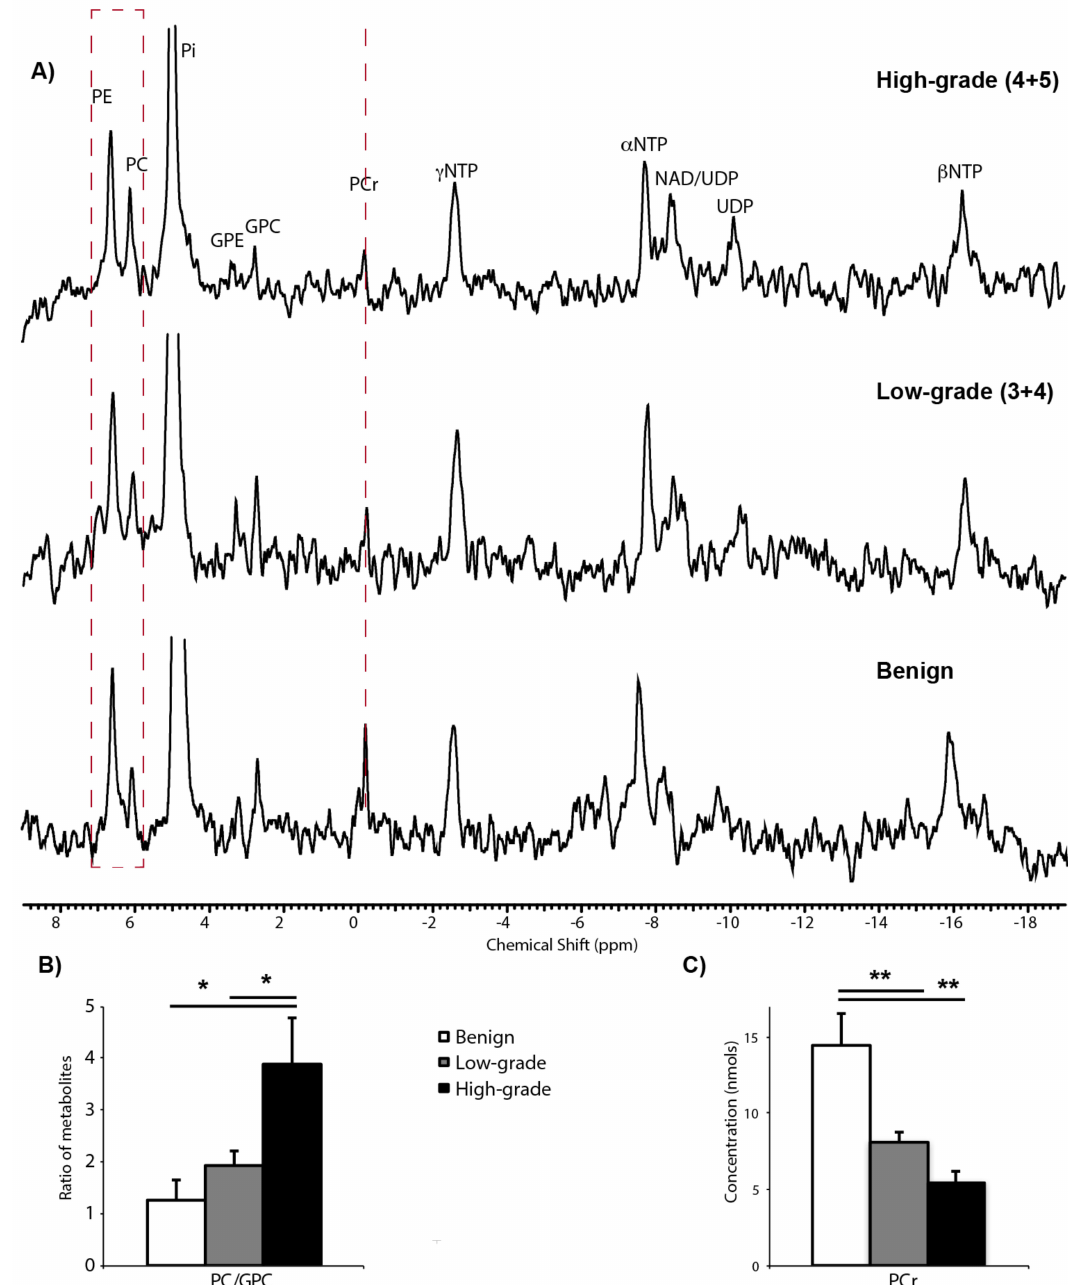
Figure 2. 31 P spectroscopy of TSCs in the 5-mm bioreactor. ( A ) Representative 31 P spectra from benign prostate tissue slice culture (TSC) (bottom spectrum), TSC containing Gleason score 3 + 4 cancer (middle spectrum, 53% of the TSC composed of cancer cells) and TSC containing Gleason score 4 + 5 cancer (top spectrum, 33% of the TSC composed of cancer cells). Resonances due to phosphomonoesters [phosphocholine (PC), phosphoethanolamine (PE)], inorganic phosphate (Pi), phosphodiesters [glycerophosphocholine (GPC), glycerophosphoethanolamine (GPE), phosphocreatine (PCr)], nucleotide triphosphates ( α , β , γ -NTPs), nicotinamide adenine dinucleotide (NAD), and uridine diphosphate (UDP) sugars are reproducibly visible in the 31 P spectra of all 3 tissue types. While the α , β , γ -NTP resonance remained relatively constant between tissue types, di ff erences were observed in the phosphomonoester and phosphocreatine regions of the 31 P spectra (dashed red lines); ( B ) Bar graphs showing significant increases in PC / GPC and ( C ) decreases in PCr concentration between benign TSCs and TSCs with low- or high-grade PCa. (* p < 0.05 and > 0.005, ** p <